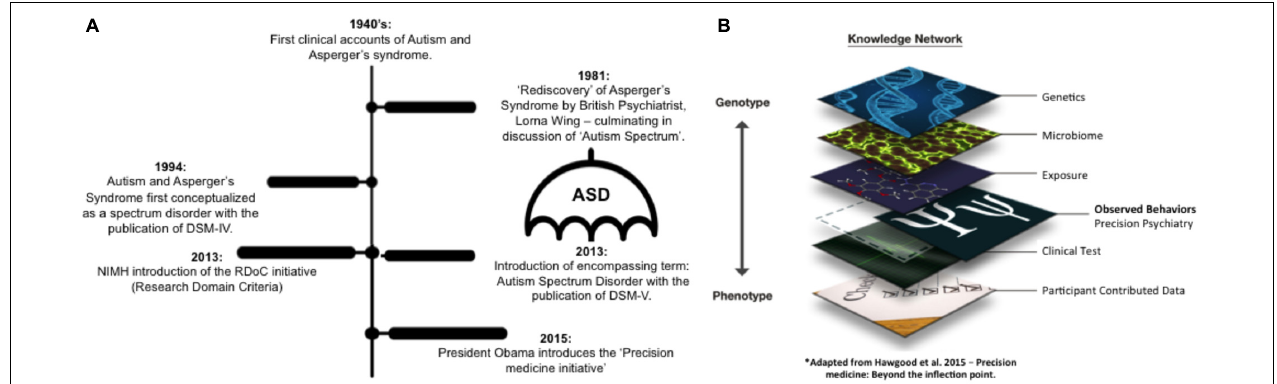
FIGURE 1 | (A) While the clinical landscape of Autism has witnessed a transformation with the amalgamation of Autism, Asperger’s syndrome and PDD-NOS into a single umbrella term of autism spectrum disorder, the new era of precision medicine (B) encourages the integration of precise individualized information toward a specific diagnosis and intervention https://figshare.com/s/eb6150e5f2fc0acd7a2c.